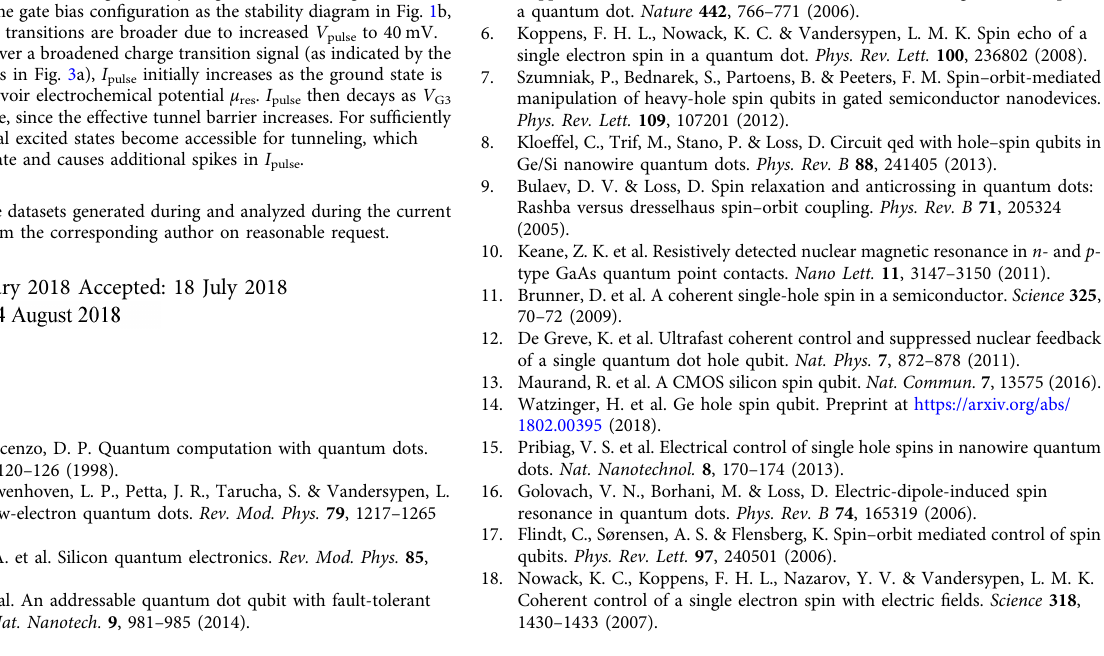
Pulse-bias spectroscopy . The charge stability diagram shown in Fig. 3a is obtained using the same gate bias con fi guration as the stability diagram in Fig. 1b, except that the charge transitions are broader due to increased V pulse to 40 mV. When sweeping V G3 over a broadened charge transition signal (as indicated by the horizontal dashed lines in Fig. 3a), I pulse initially increases as the ground state is pulsed below the reservoir electrochemical potential μ res . I pulse then decays as V G3 becomes more negative, since the effective tunnel barrier increases. For suf fi ciently negative V G3 additional excited states become accessible for tunneling, which increases the tunnel rate and causes additional spikes in I pulse .